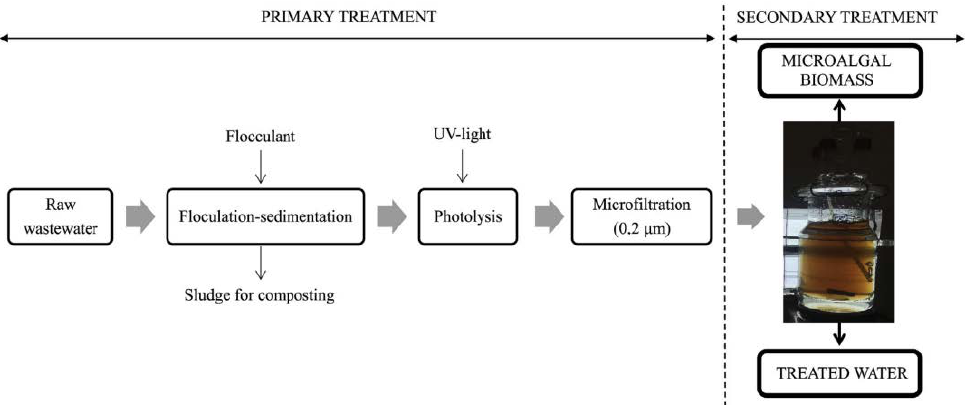
Figure 5. Integrated process for OMW treatment and the generation of high added value algal bio- mass. Reprinted with permission from Reference [74]. Copyright 2019. Elsevier. biomass. Reprinted with permission from Reference [74]. Copyright 2019. According to their results, the COD reduction was 57.5%, 88.8%, and 20.5% by the flocculation, photolysis and microfiltration, respectively [74].